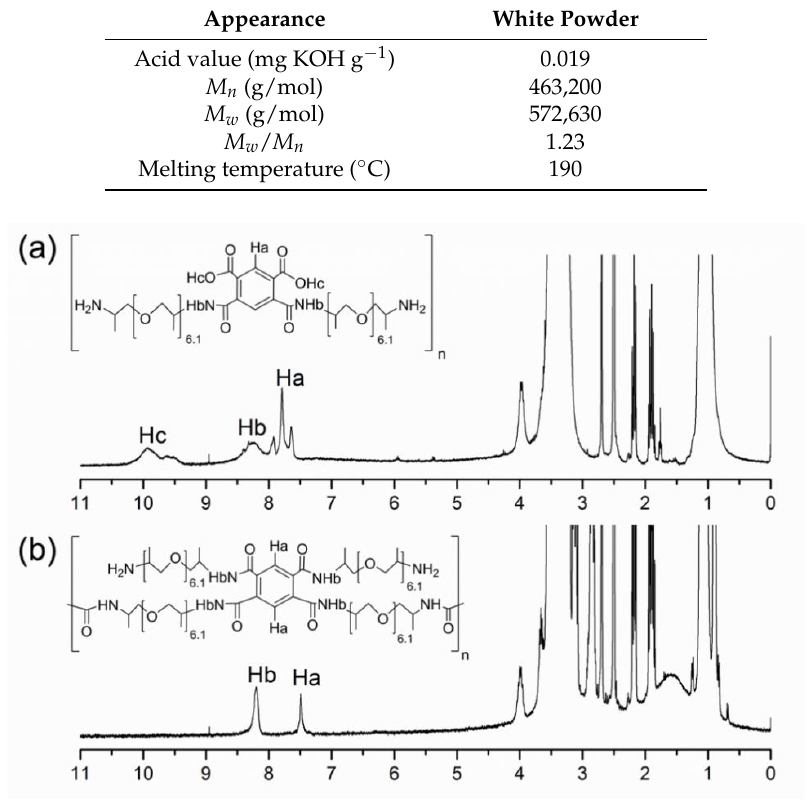
Figure 4. 1 H-NMR spectra of ( a ) amic acid and ( b ) BTCP.